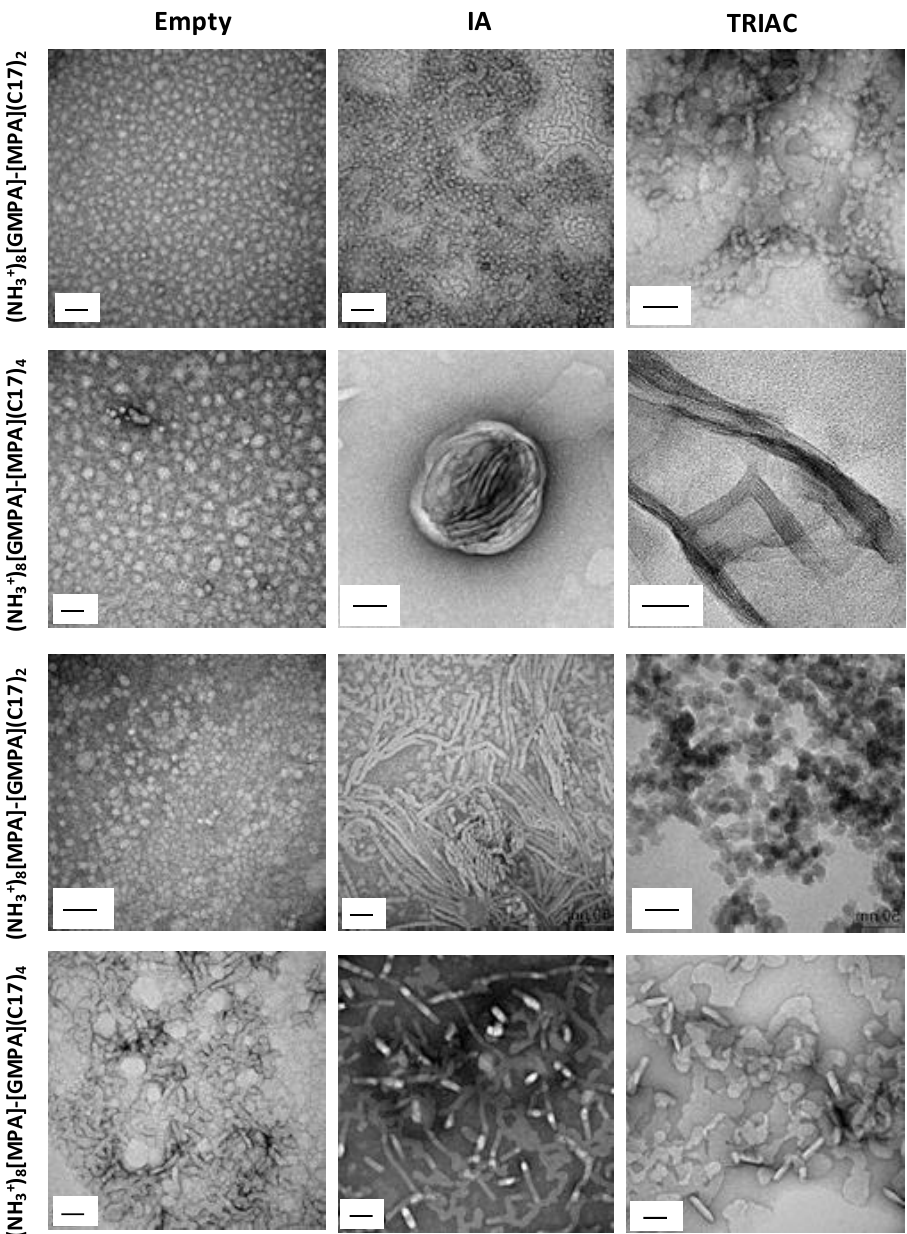
Figure 3. TEM images of the empty Janus dendrimer aggregates (first column) and loaded with IA (second column) or TRIAC (third column). Scale size: 50 nm.